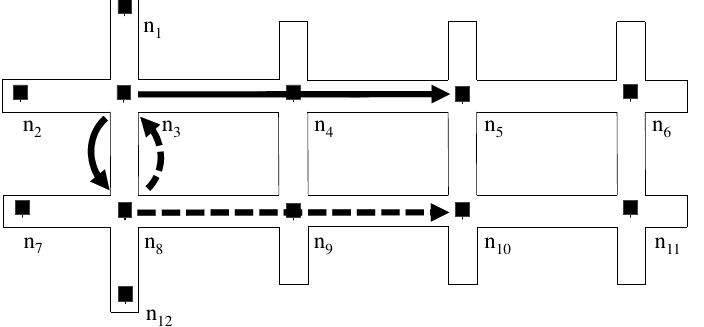
Figure 4. The Routing Loop Problem: When the secondary relay for a destination at n 3 is n 8 and the one at n 8 is n 3 , packets on secondary paths would make routing loops.